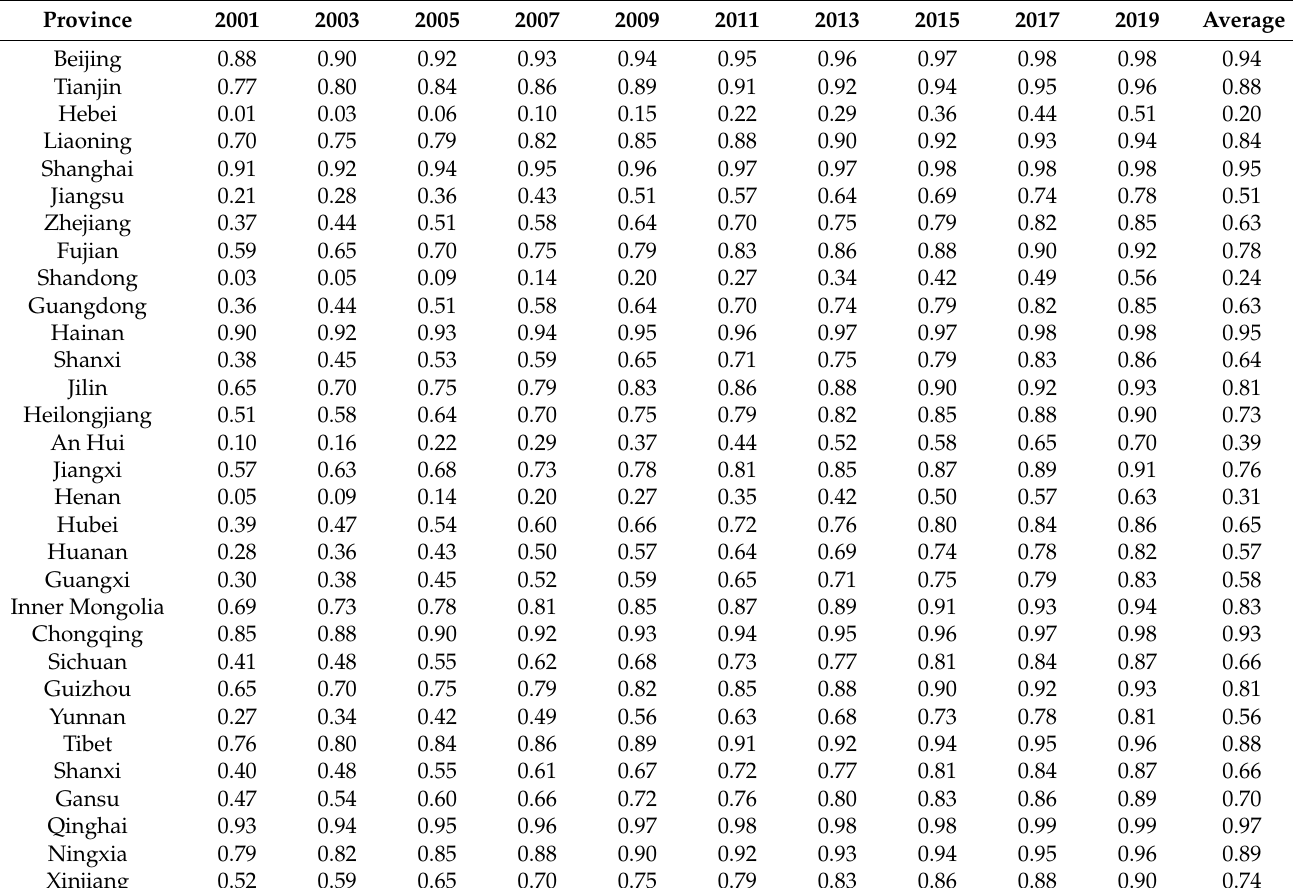
Table 3. Provincial green production efficiency of grain from 2001 to